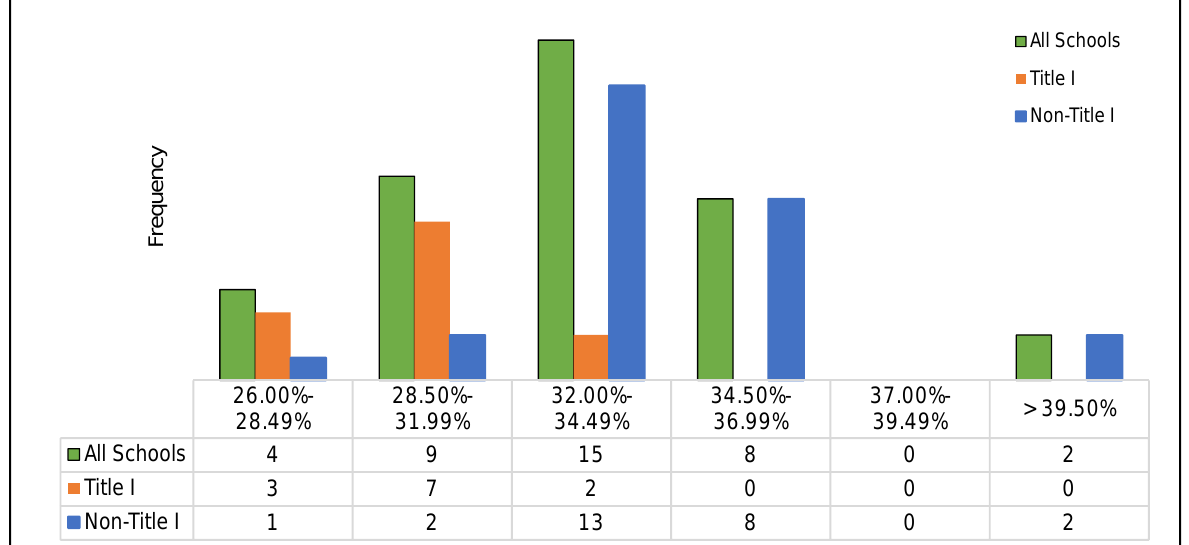
Figure 5. Histogram for Locally Sourced Fresh Florida Products in 2014–2015 Academic Year for All Schools Segmented by Title I and Non–Title I Classification in Sarasota